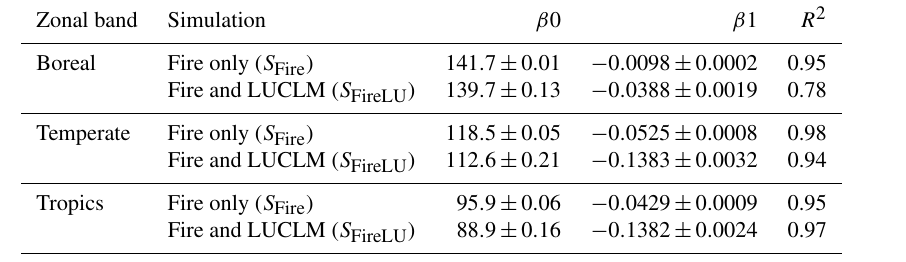
Table 3. Linear trend statistics by zonal band from LPJ-wsl v2.0 simulations, based on model (age = β 0 + β 1 · year), where the year at 1860 is indexed at 1. Coefficients listed as µ ± S.E. All DoFs are 113 and p < 0 . 001.